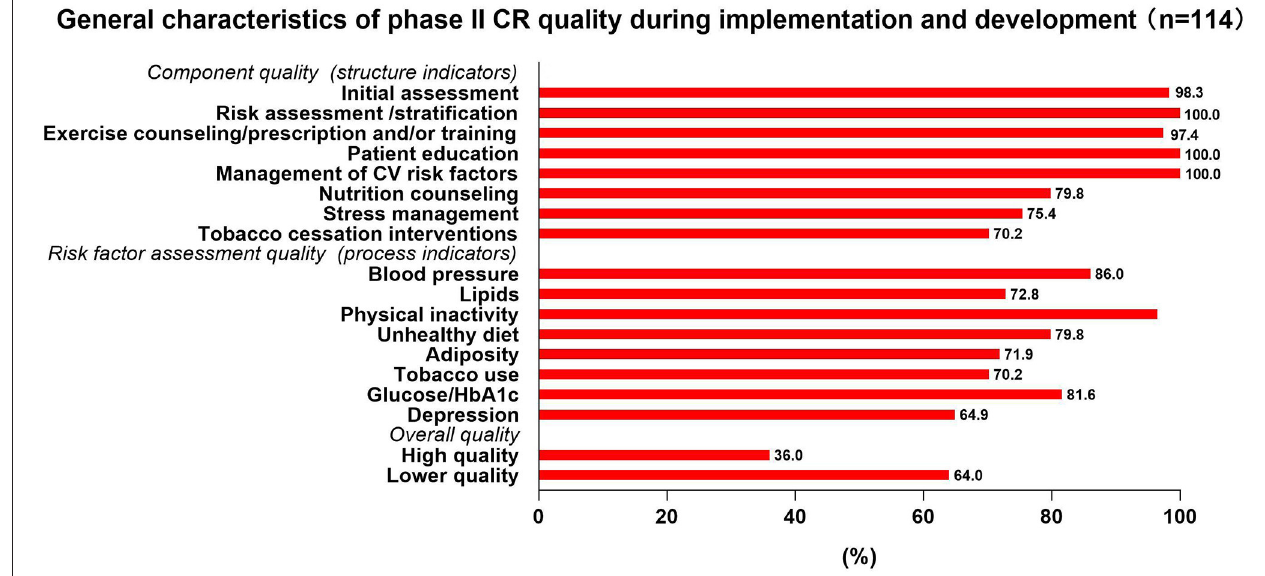
FIGURE 4 | General characteristics of phase II cardiac rehabilitation (CR) quality during implementation and